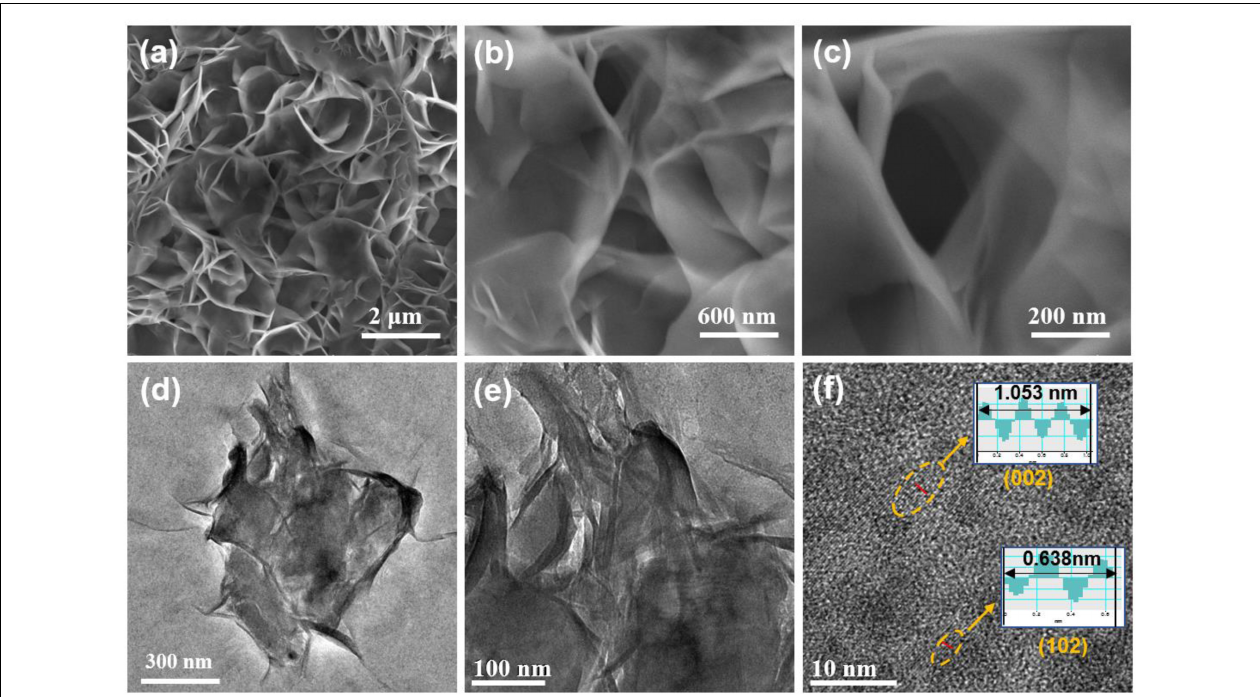
FIGURE 2 | FESEM images of the VOPO 4 · 2H 2 O nanosheets with different magnifications (a–c) ; TEM images of the VOPO 4 · 2H 2 O nanosheets (d,e) ; HRTEM image of the VOPO 4 · 2H 2 O nanosheets (f)